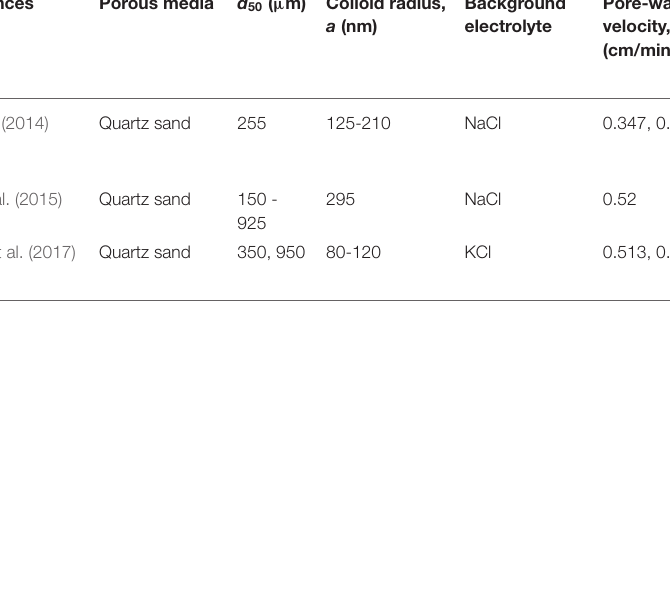
TABLE 4 | Experimental conditions in papers selected to analyse deposition of Ag